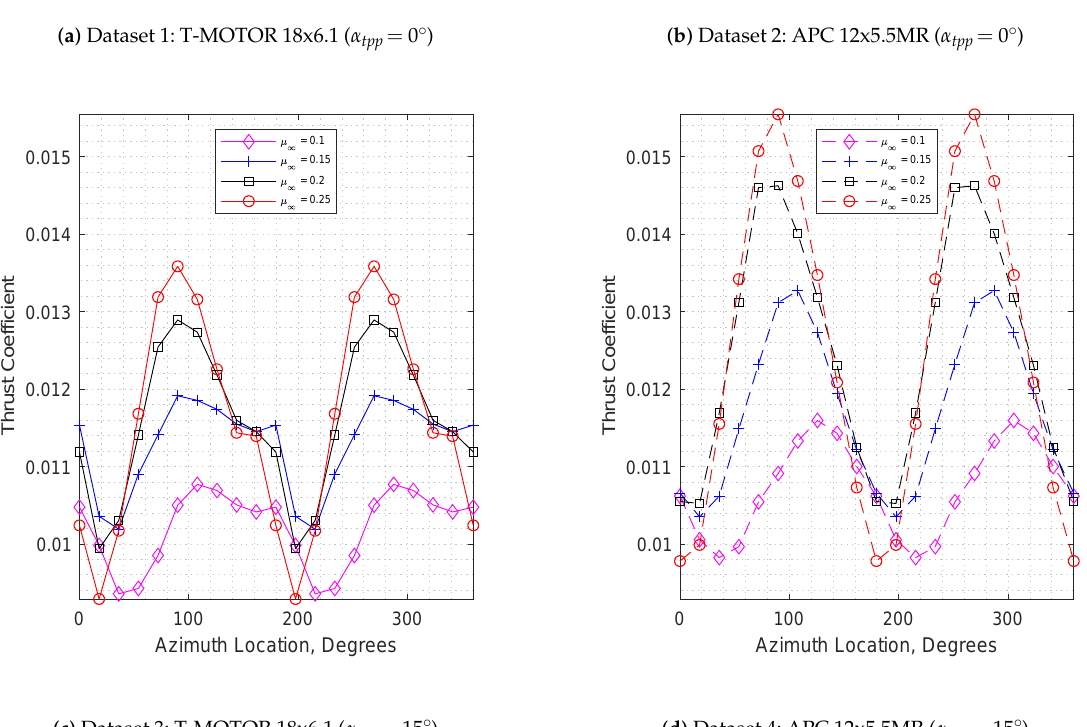
Figure 12. Thrust coefficient vs. azimuth location as predicted with the DDE method. Most of the cases shown in Fig. 12, except for those shown in Fig. 12d, have 328 small secondary peaks occurring roughly 20 corresponding to a primary and secondary peak for the case of µ ∞ = 0.25 in Fig. 12b. 331